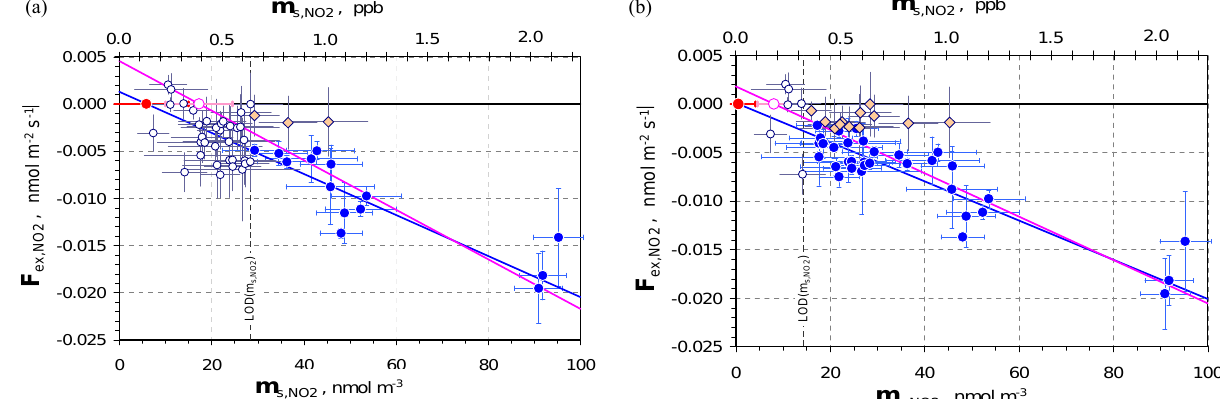
Fig. 11. Laboratory NO 2 fumigation of 3–4yr old Norway Spruce trees ( Picea abies L.) under controlled conditions (25 ◦ C, 60%, Figure 11. Laboratory NO 2 fumigation of 3 - 4yr old Norway Spruce trees ( Picea abies L.) under controlled conditions (25 °C, 60 %, 15 450 µmolphotonsm − 2 s − 1 ): NO 2 exchange flux density ( F ex,NO ) vs. NO 2 concentration measured at the outlet of the dynamic plant 450 µmol photons m -2 s -1 ): NO 2 exchange flux density ( F ex,NO2 ) vs. NO 2 concentration measured at the outlet of the dynamic plant chamber 16 2 chamber ( m s,NO ) for application of 2 σ -LOD( m s,NO )-definition (a) and 1 σ -LOD( m s,NO )-definition (b) . F ex,NO data were calculated ac- 2 2 2 2 ( m s,NO2 ) for application of 2  - LOD ( m s,NO2 )-definition ( (a) panel) and 1  - LOD ( m s,NO2 )-definition ( (b) panel). F ex,NO2 data were calculated 17 > LOD( m s,NO cording Eq. (2), their standard errors according to Eq. (14). Blue circles identify F ex,NO where m s,NO ), white circles stand 2 2 2 ≤ LOD( m for F ex,NO where m s,NO s,NO 2 ), and reddish diamonds for those F ex,NO 2 data, which have to be rejected for non-significance of 2 2 − m 1m NO =( m a,NO s,NO 2 ). Blue line (considering blue circle data) and pink line (considering blue circle and reddish diamond data) are 2 2 calculated according to Eq. (9). NO 2 compensation point concentration m comp,NO is calculated according to Eq. (11) and is represented by 2 red filled circles (considering blue circle data) and pink hollow circles (considering blue circle and reddish diamond data). More details of statistical evaluation are listed in Table